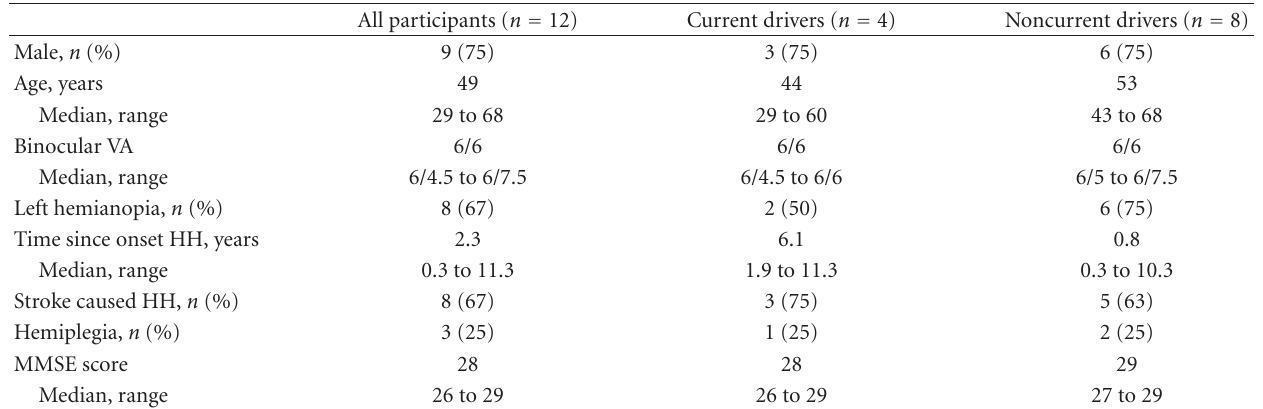
Table 1: Characteristics of the participants with